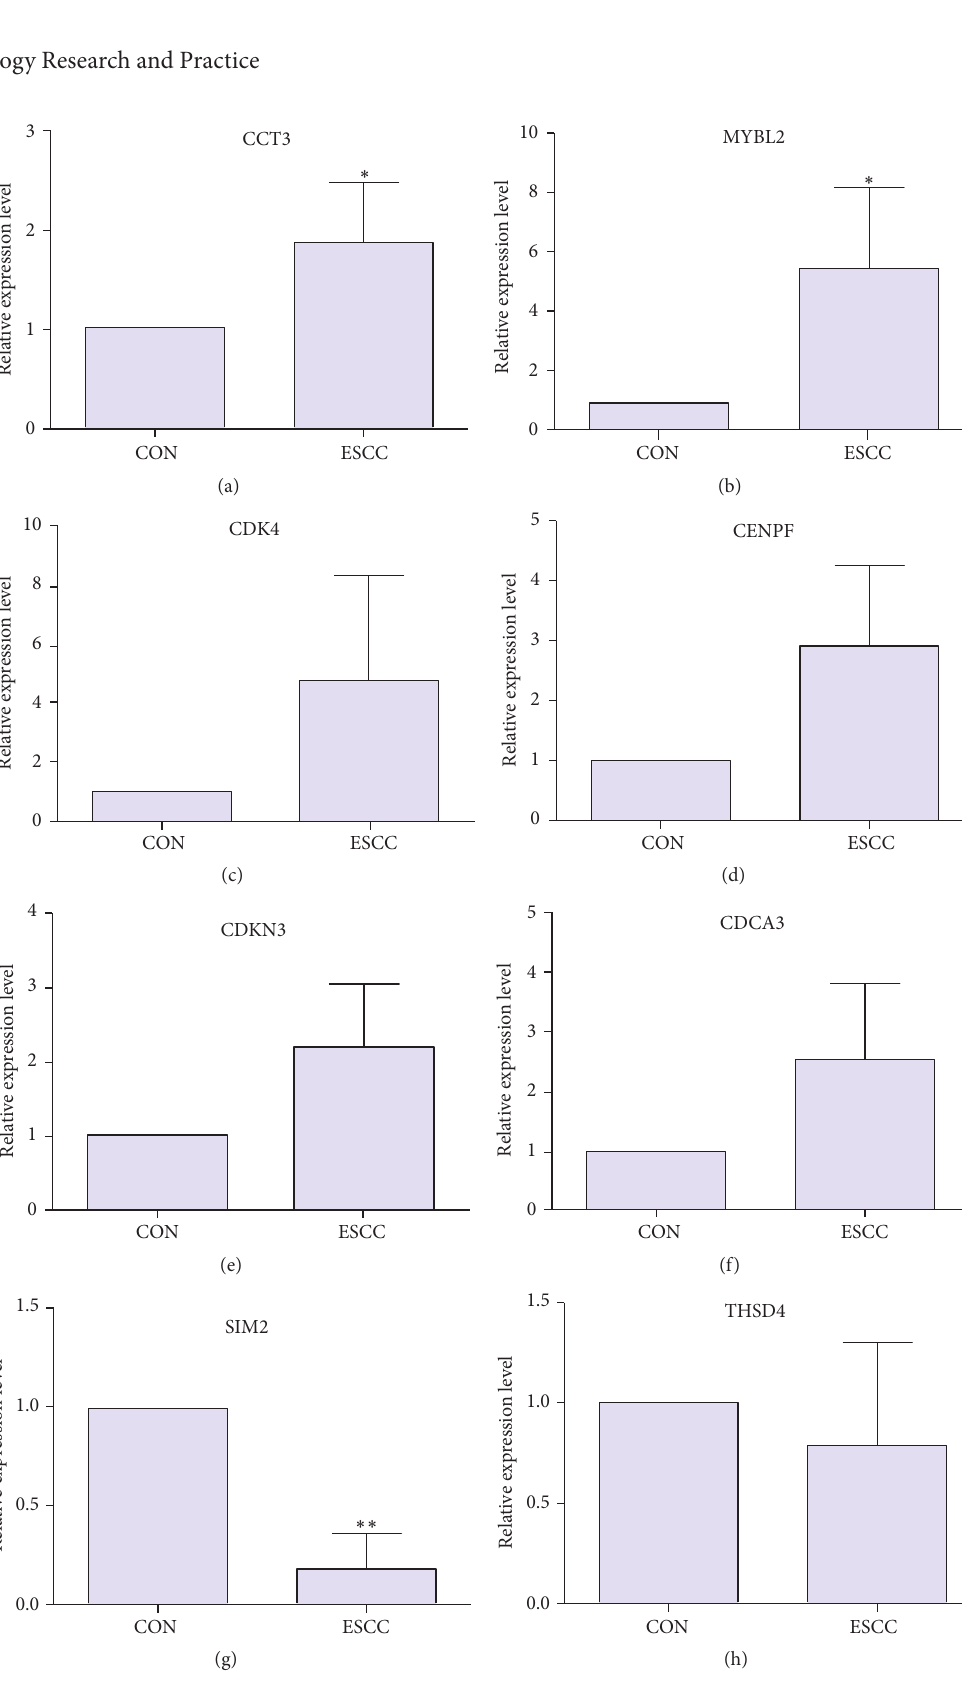
Figure 2: The qRT-PCR validation of the expression level of DEGs in EC compared to adjacent nontumor tissues. (a) CCT3; (b) MYBL2; (c) CDK4; (d) CENPF; (e) CDKN3; (f) CDCA3; (g) SIM2; (h) THSD4. EC: esophageal carcinoma; CON: adjacent nontumor tissues of ESCC. At least three independent experiments were performed for statistical evaluation. qRT-PCR experimental data were expressed as means ±